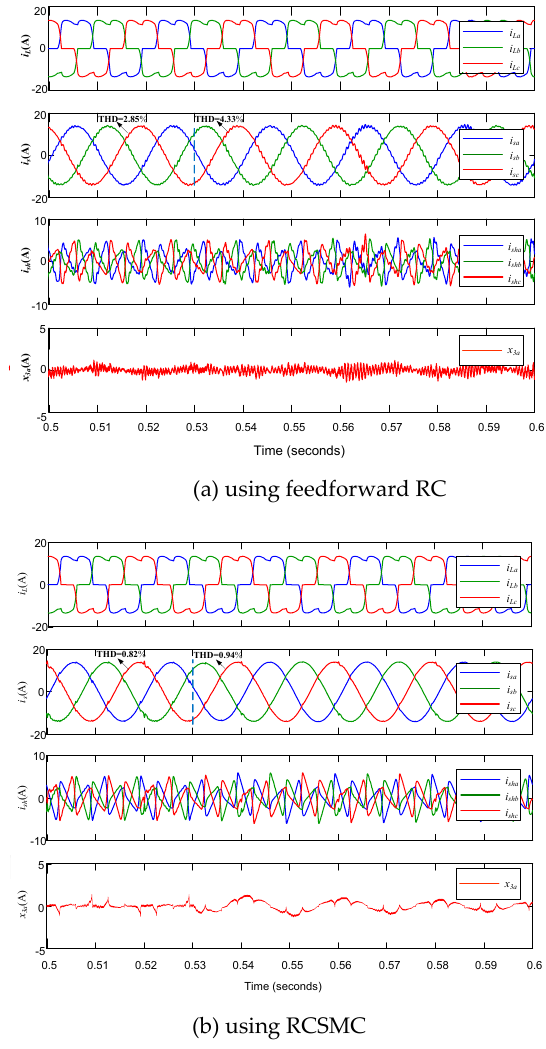
Figure 10. Simulation waveform of SAPF in dynamic state when the grid impedance changes.